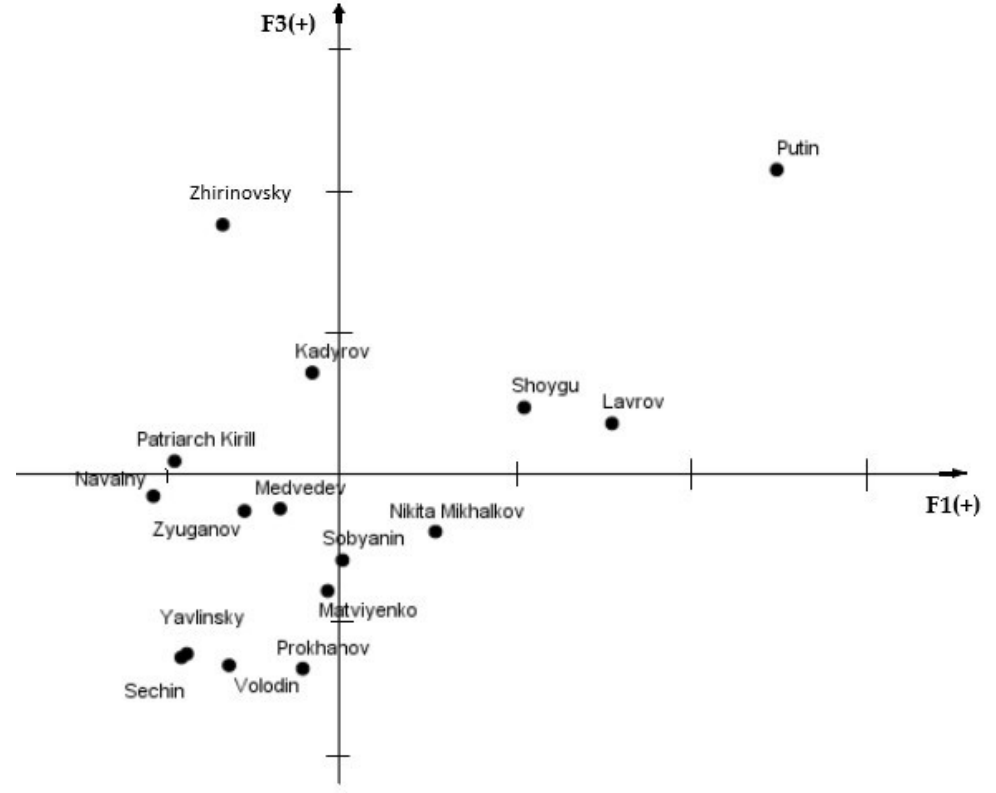
Figure 2. Positions of the images of Russian political leaders: F1—morality, F3—charisma.